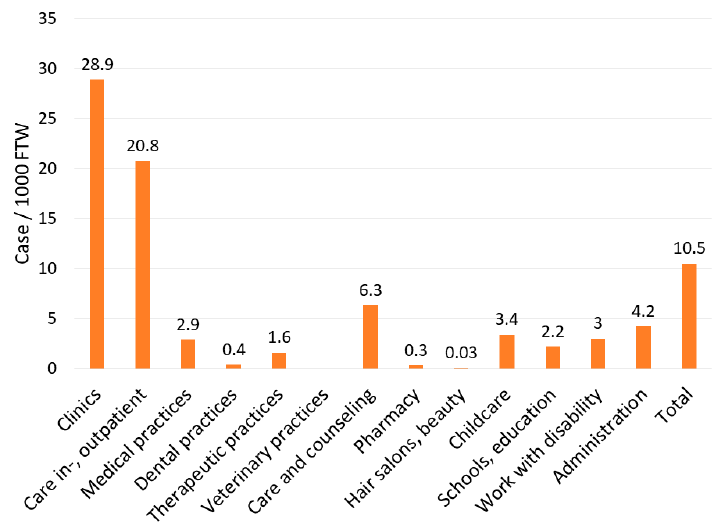
Figure 1. Number of occupational diseases (OD) due to COVID-19 per 1000 full-time workers (FTW) by sector. Of the 84,728 claims, 375 (0.4%) workers were hospitalized and 77 died (0.09%). The majority of workers in need of hospital treatment come from clinics (52.3%) and inpatient and outpatient care facilities (28.0%) (Table 2). Correspondingly, the hospitalization rate per 100,000 FTW is highest for clinics (25.4), followed by inpatient and outpatient care (10.5) and medical practices (8.7). Again, the majority of workers who died because of COVID-19 come from clinics or in- and outpatient care ( n = 22, or 28.6% each). The third most affected sector are facilities for occupational rehabilitation and workplaces for people with disabilities ( n = 12) (see work with disability in Figure 1). The rate of death per 100,000 FTW was as high as for clinics (2.9), though the hospitalization rate per FTW differed (0.2 versus 25.4). Table 2. Hospitalization or death of COVID-19 cases reported to accident insurance provider BGW by sector. Sector